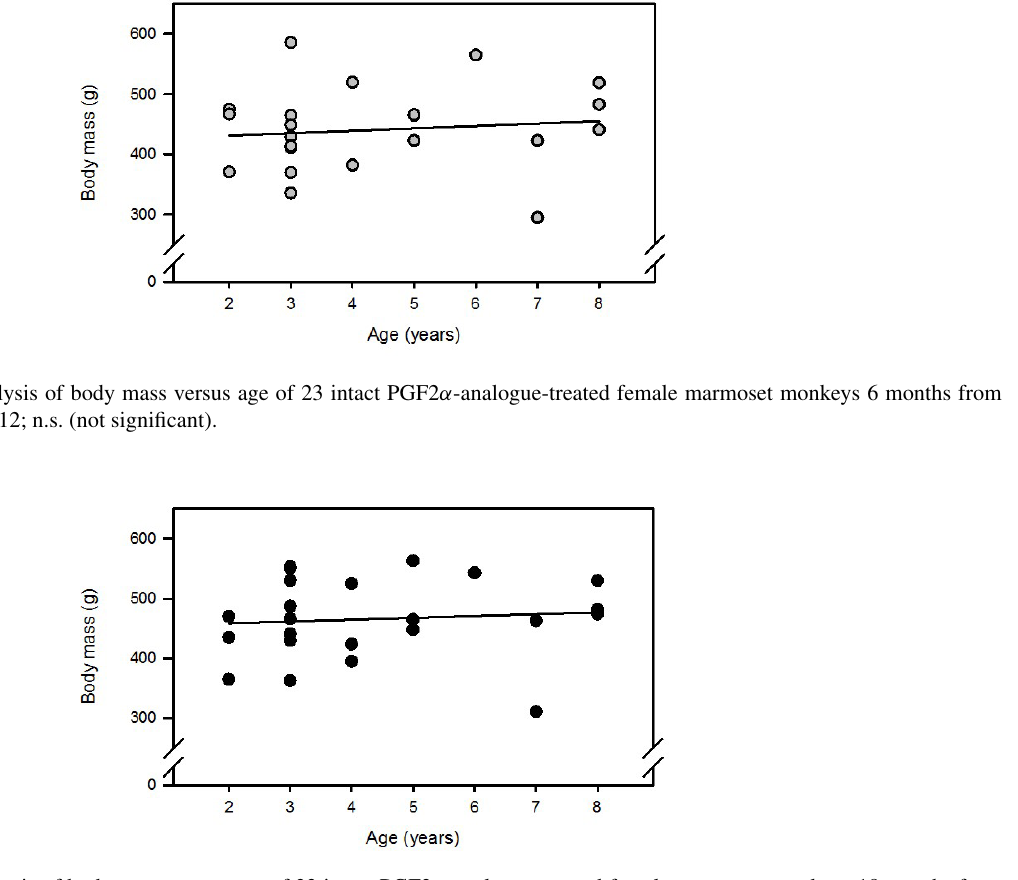
Figure A2. Regression analysis of body mass versus age of 23 intact PGF2 α -analogue-treated female marmoset monkeys 18 months from their last parturition. R = 0 . 09; n.s. (not significant).